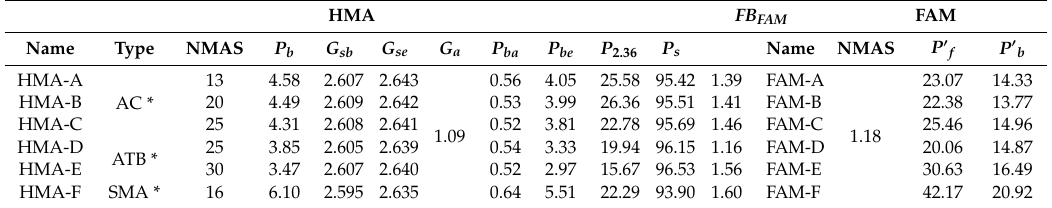
Table 1. Parameters related to the determination of asphalt content in FAM (percentage) HMA FB FAM